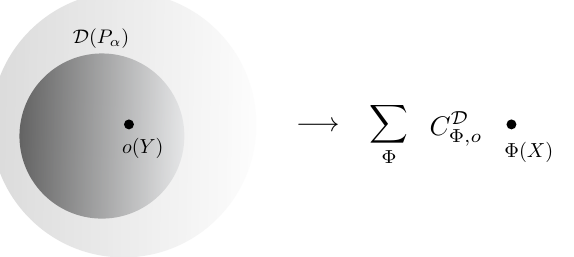
Figure 4 . The quantization slice encloses the defect. The state induced on the sphere is expanded in terms of bulk local